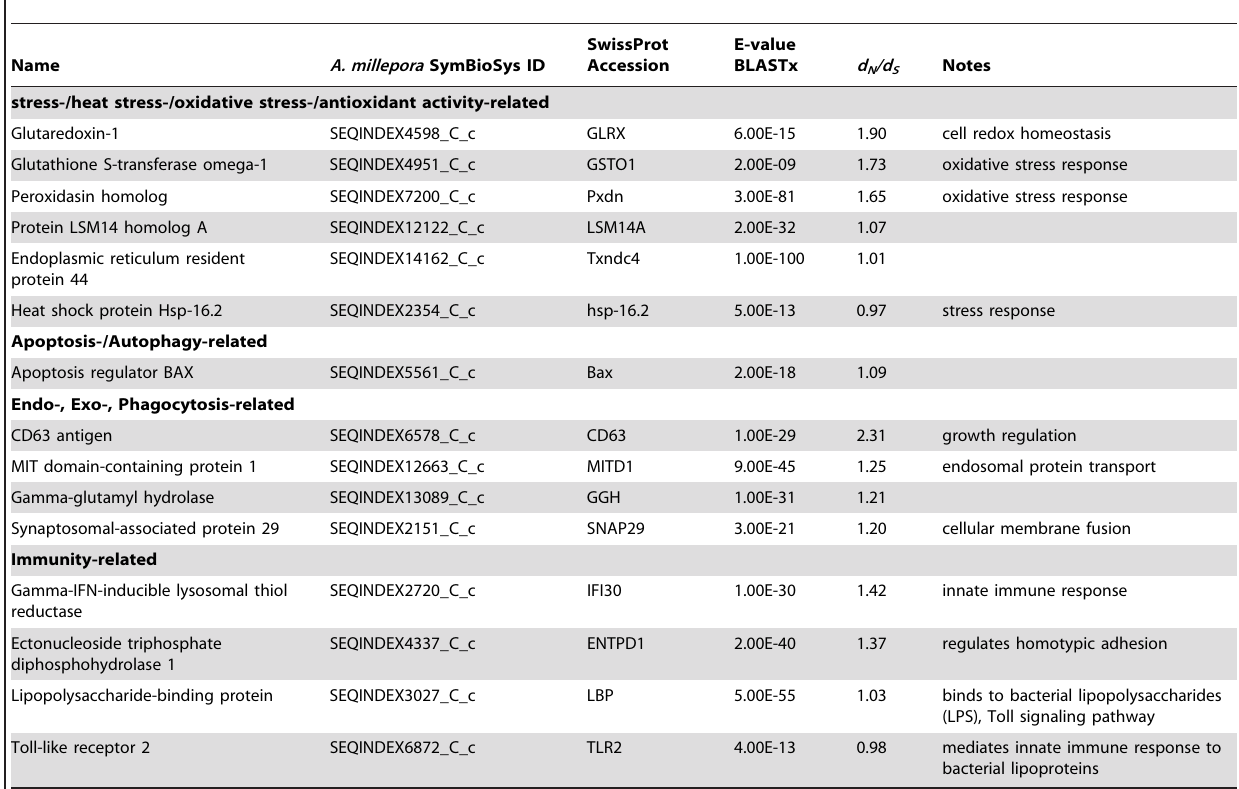
Table 4. Potential symbiosis-related genes displaying elevated rates of evolution identified from the transcriptomes of A. millepora and A.